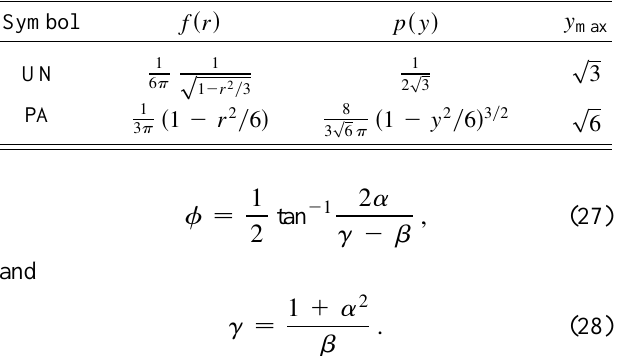
TABLE IV. Normalized expressions of distribution functions in our simulation. The symbols UN and PA stand for uniform and parabolic distributions, respectively. f (cid:2) r (cid:3) is the density in phase space as a function of radius r 2 (cid:1) y 2 1 y 0 2 , and p (cid:2) y (cid:3) is the projection on real